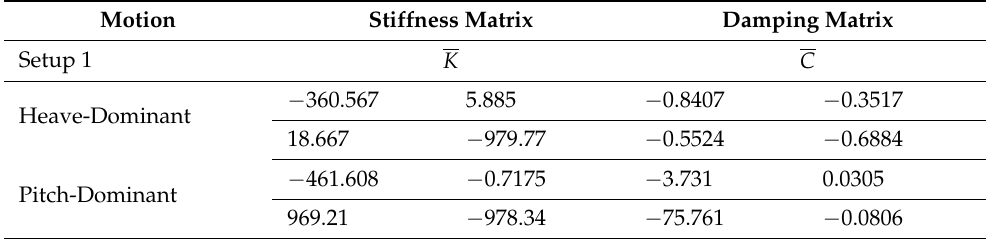
Table 5. Mechanical system matrices for wind-off conditions from the ILS method. Motion Stiffness